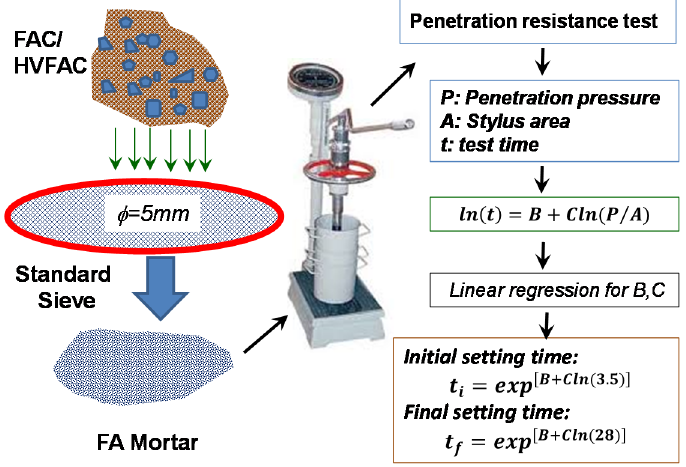
Figure 2. Instrument and method for the test of setting time. HVFAC, high volume fly ash concrete. FAC, fly ash concrete.